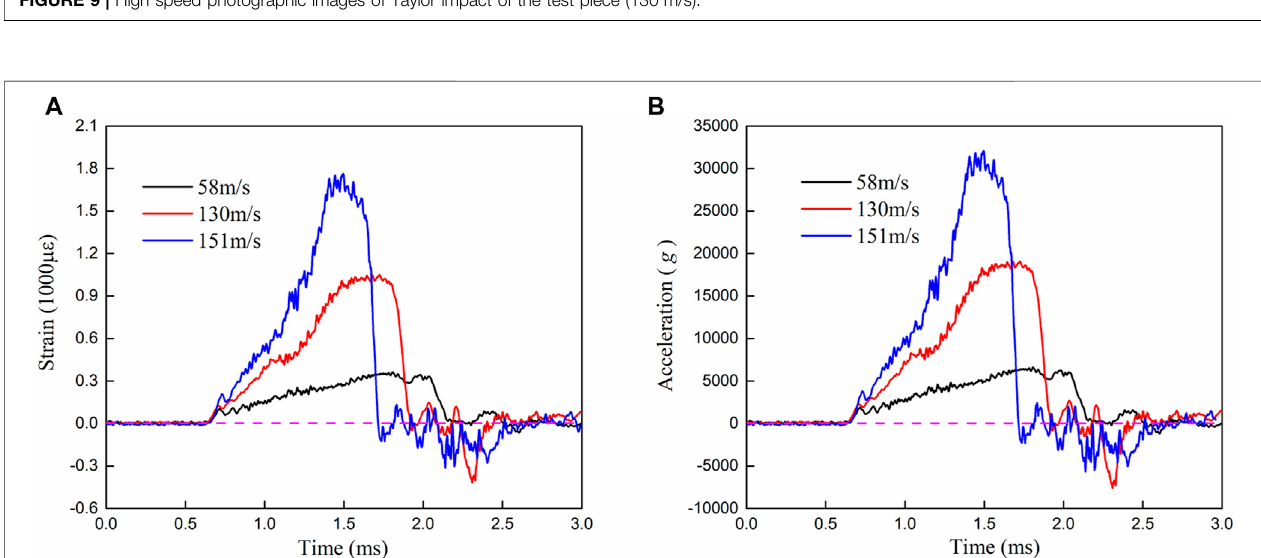
FIGURE 9 | High speed photographic images of Taylor impact of the test piece (130 m/s).